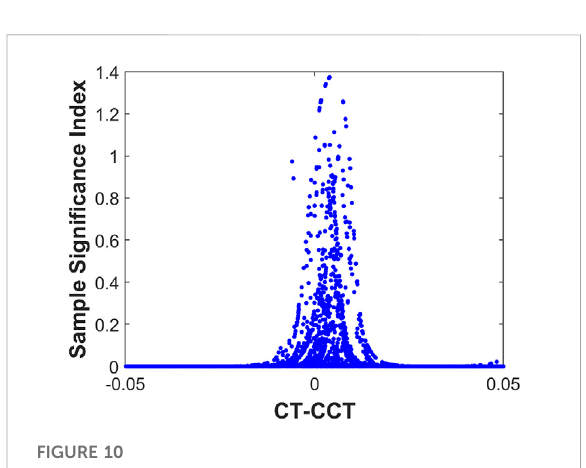
FIGURE 10 Sample Signi fi cance Index distribution with relative clearing